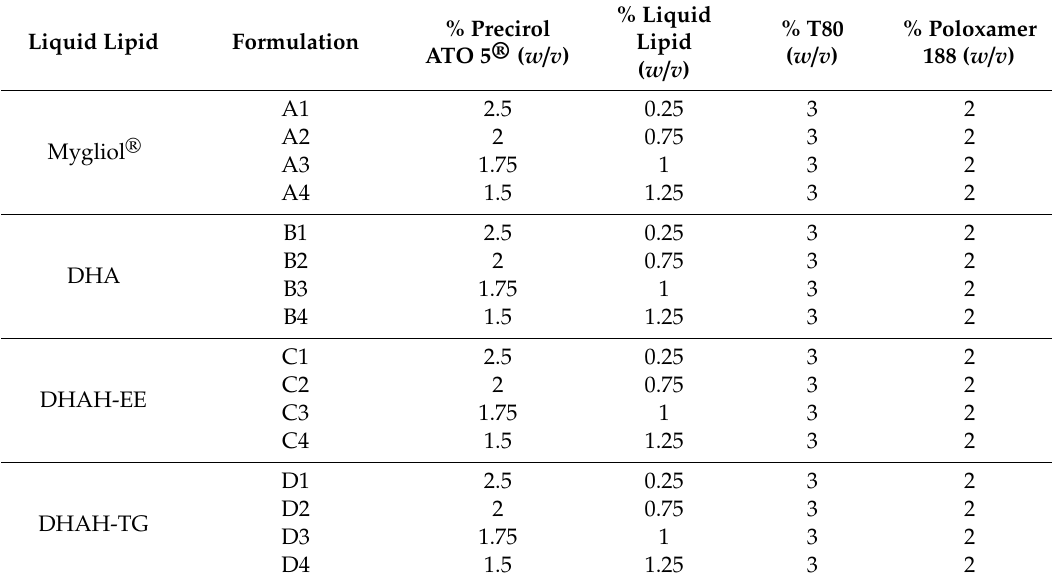
Table 1. The composition of the di ff erent nanoparticles, using Precirol ® ATO 5 and di ff erent Ω -3 fatty acids or Mygliol ® as a liquid lipid with di ff erent solid:liquid lipid ratios.